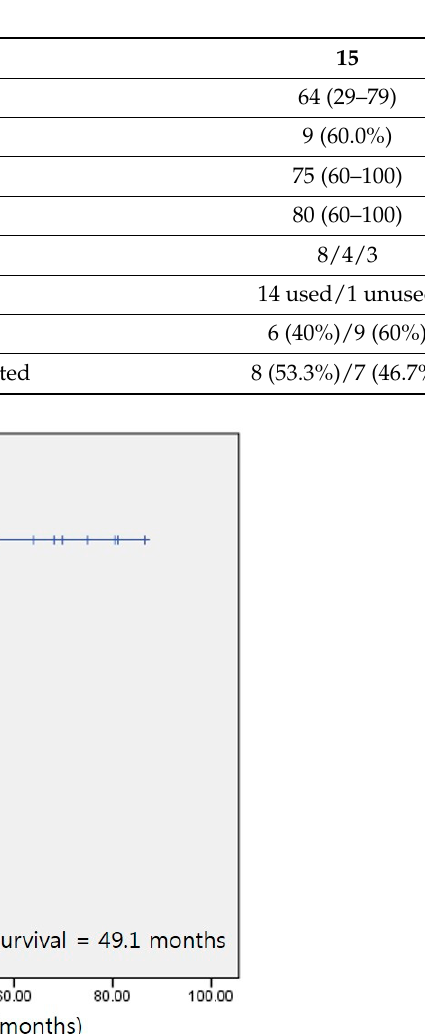
Table 1. Patient characteristics.